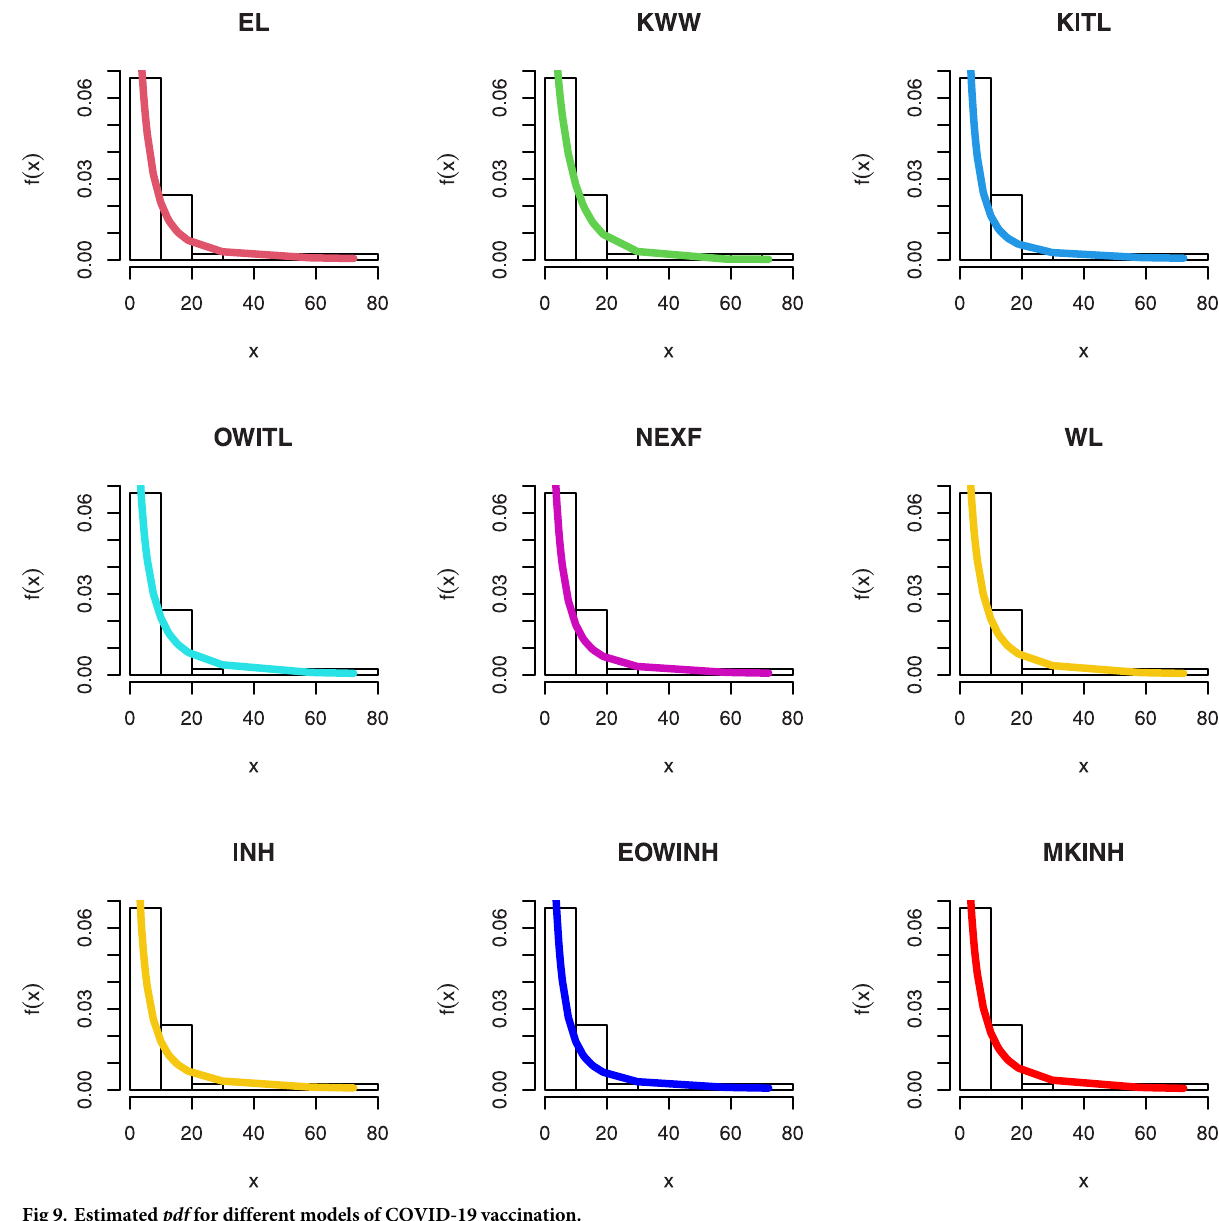
Fig 9. Estimated pdf for different models of COVID-19 vaccination.